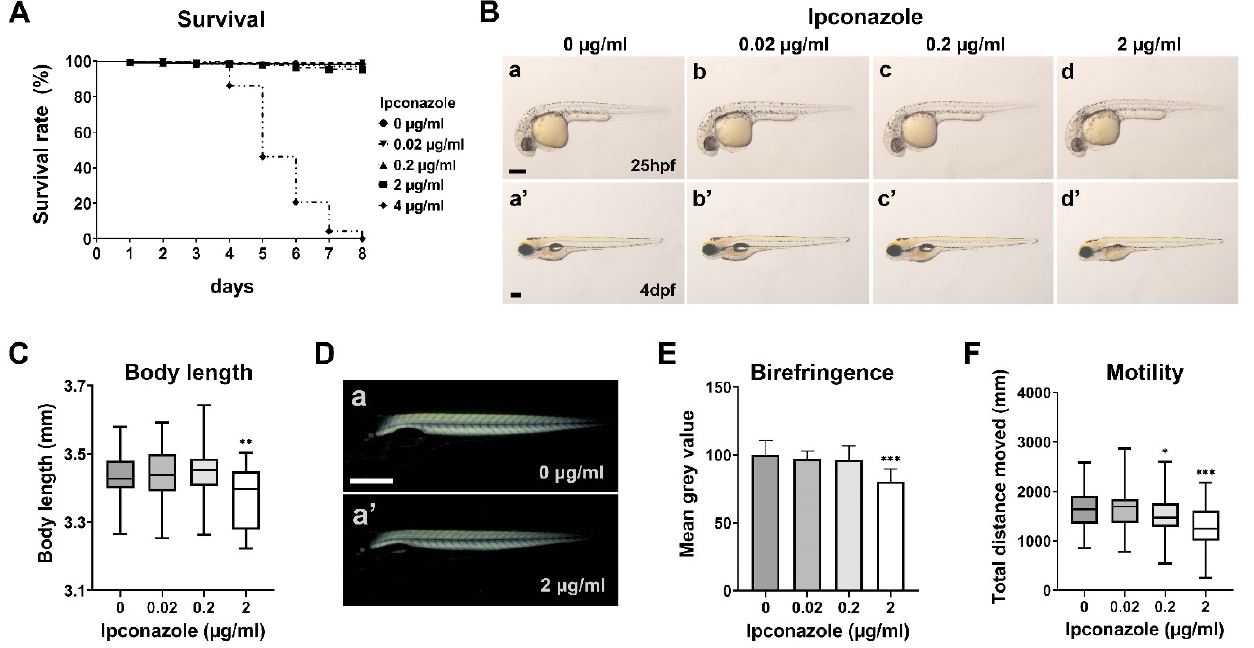
Figure 1. Ipconazole alters larval locomotive behavior in zebrafish development. ( A ) Survival rate (%) of zebrafish larvae treated with ipconazole, repeated six times ( n = 300 each); ( B ) lateral views of the bright field imaging of the embryos at 25 h post fertilization (hpf) ( a – d ) and 4 days post fertilization (dpf) ( a’ – d’ ), repeated four times ( n = 40 each), scale bar, 500 µ m; ( C ) body length of the larvae treated with ipconazole at 4 dpf; ( D ) lateral views of 3-dpf larvae subjected to polarized light microscopy ( a , a’ ), scale bar, 500 µ m; ( E ) quantitation of the average birefringence of the larval muscle, repeated three times ( n = 30 each); ( F ) locomotor activity of 6-dpf larvae treated with ipconazole. Graphical representation of the average distance traveled in the dark condition. * p < 0.05, ** p < 0.01, *** p < 0.001.